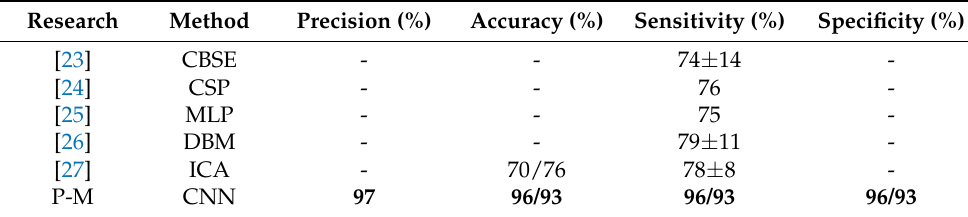
Table 3. The proposed method compared with previous studies.